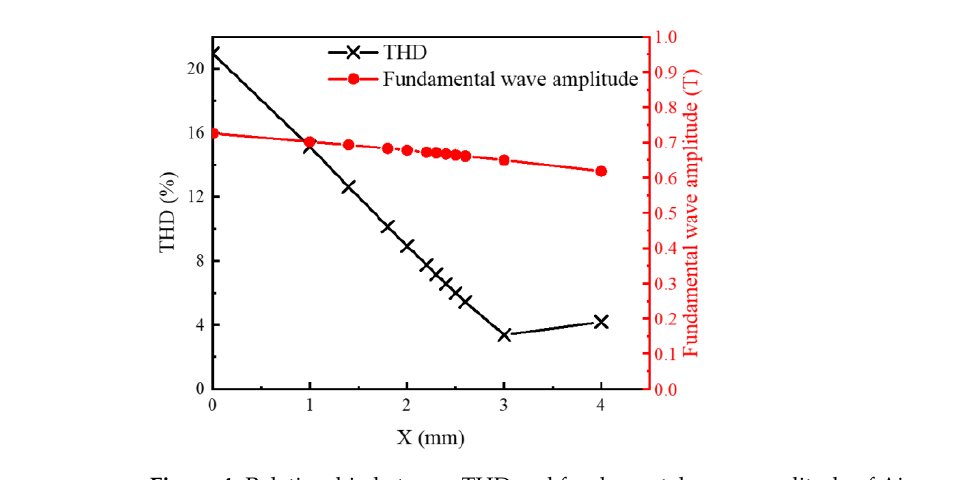
Figure 3. ( a ) Schematic diagram of eccentric pole cutting magnetic ring. ( b ) Magnetization simula- tion cloud chart.